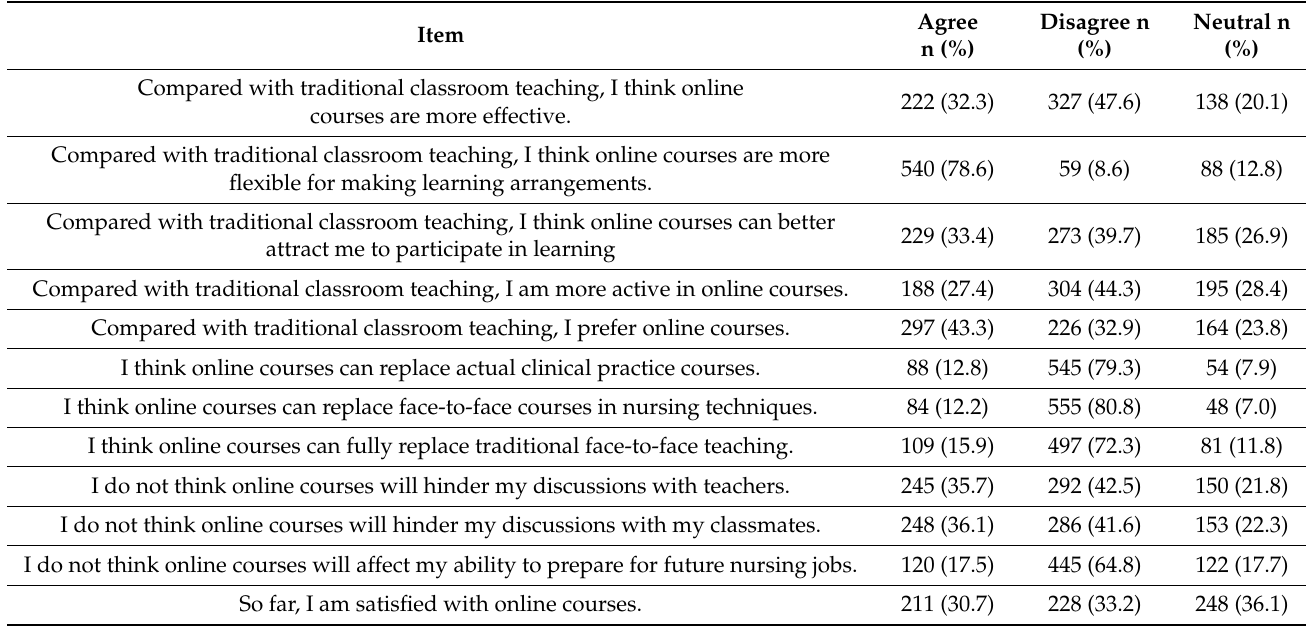
Table 2. Attitude toward the online courses (n =